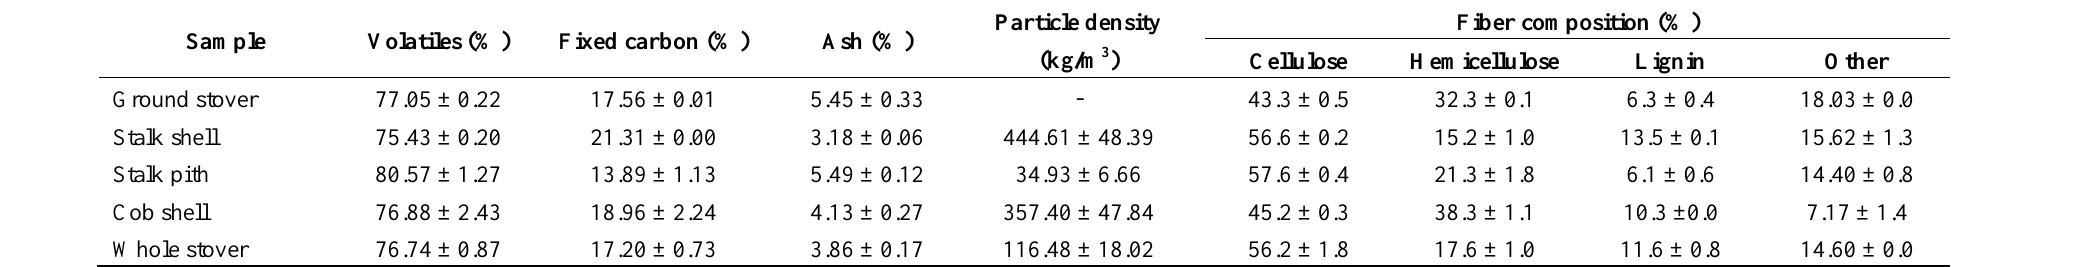
Table 2. Proximate analysis of raw corn stover biomass.